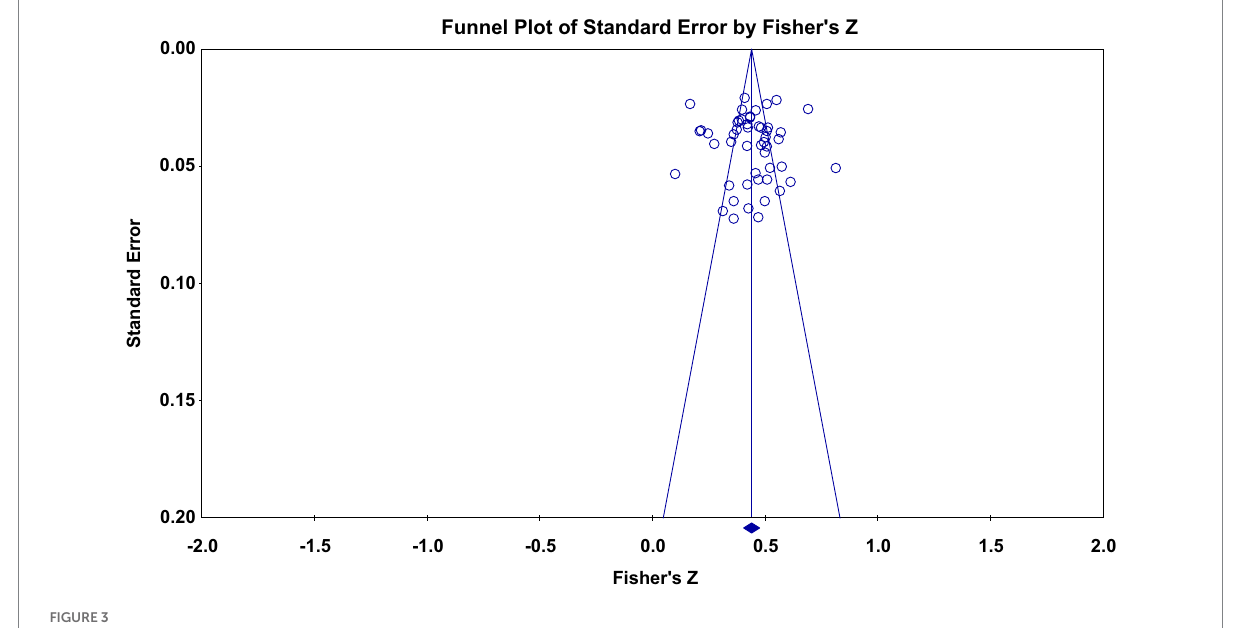
FIGURE 3 Funnel plot of effect sizes of the correlation between AB and